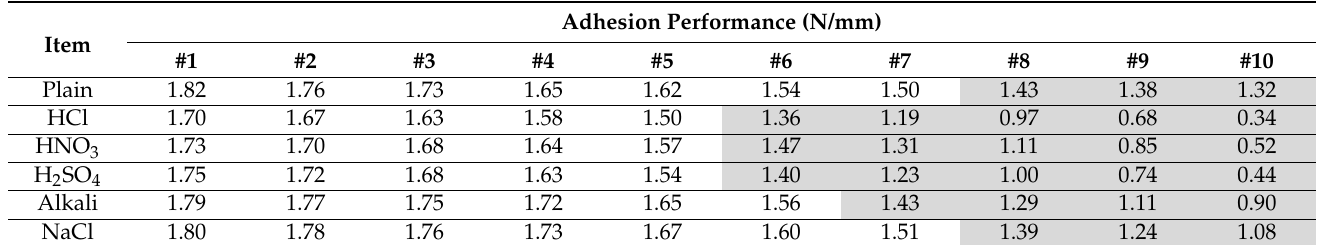
Table 11. Adhesion performance between sheet joint.